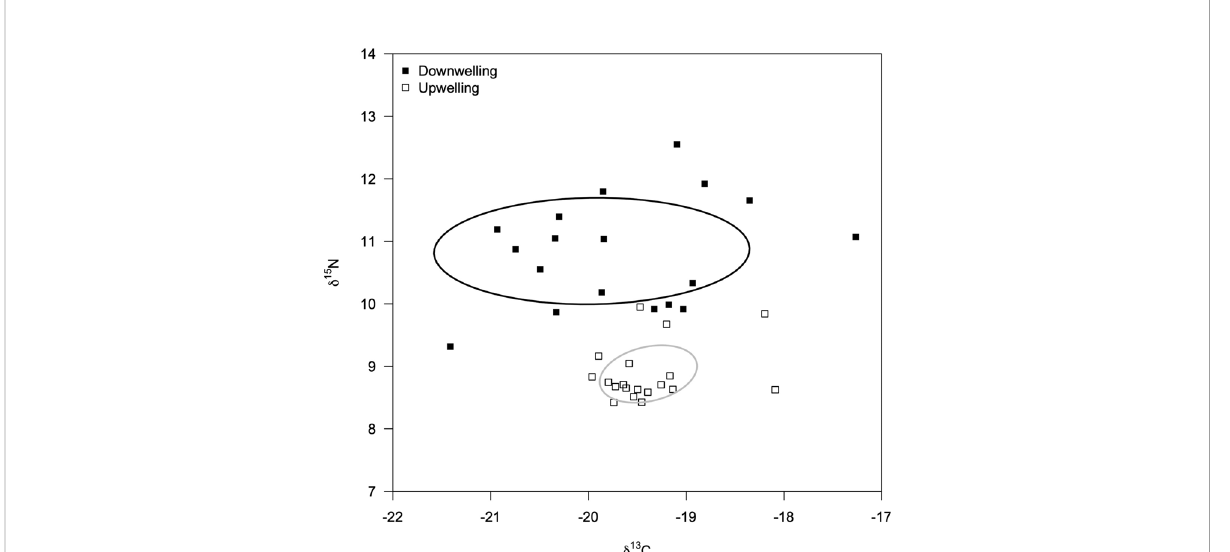
FIGURE 2 Isotopic niche area of Carcinus maenas females ( d 13 C and d 15 N; ‰ ) inferred from embryonic tissues collected during downwelling ( n = 20 females) and upwelling ( n = 20 females) events. Stage 1 and stage 3 embryos were combined for each event given their due to similar isotopic pro fi les (MANOVA, p = 0.32) The standard Bayesian Ellipse areas are shown for each supply